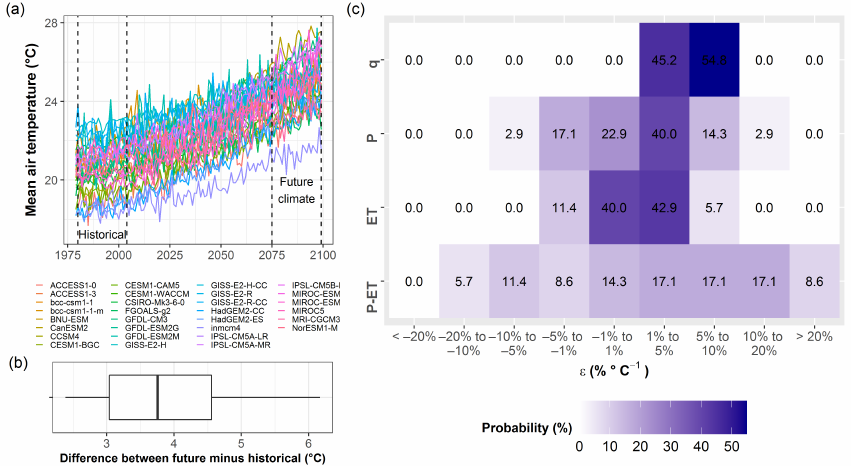
Figure 2. ( a ) Mean annual air temperature ( ◦ C) projected by CMIP5 climate models from 1980 to 2099; ( b ) boxplot of the difference between future minus historical time slices of mean air temperature ( ◦ C); ( c ) probabilities of occurrence (%) of elasticity to temperature for precipitation ( P ), specific humidity ( q ), evapotranspiration (ET), and precipitation minus evapotranspiration ( P -ET), in % ◦ C − 1